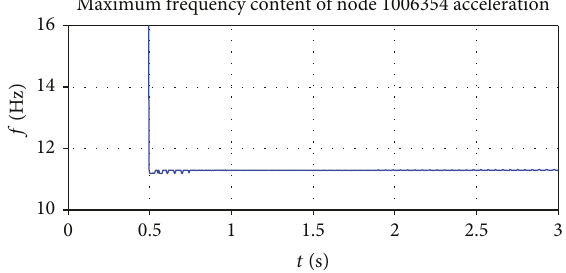
Figure 27: D3, decay test CWT, acceleration in the damaged